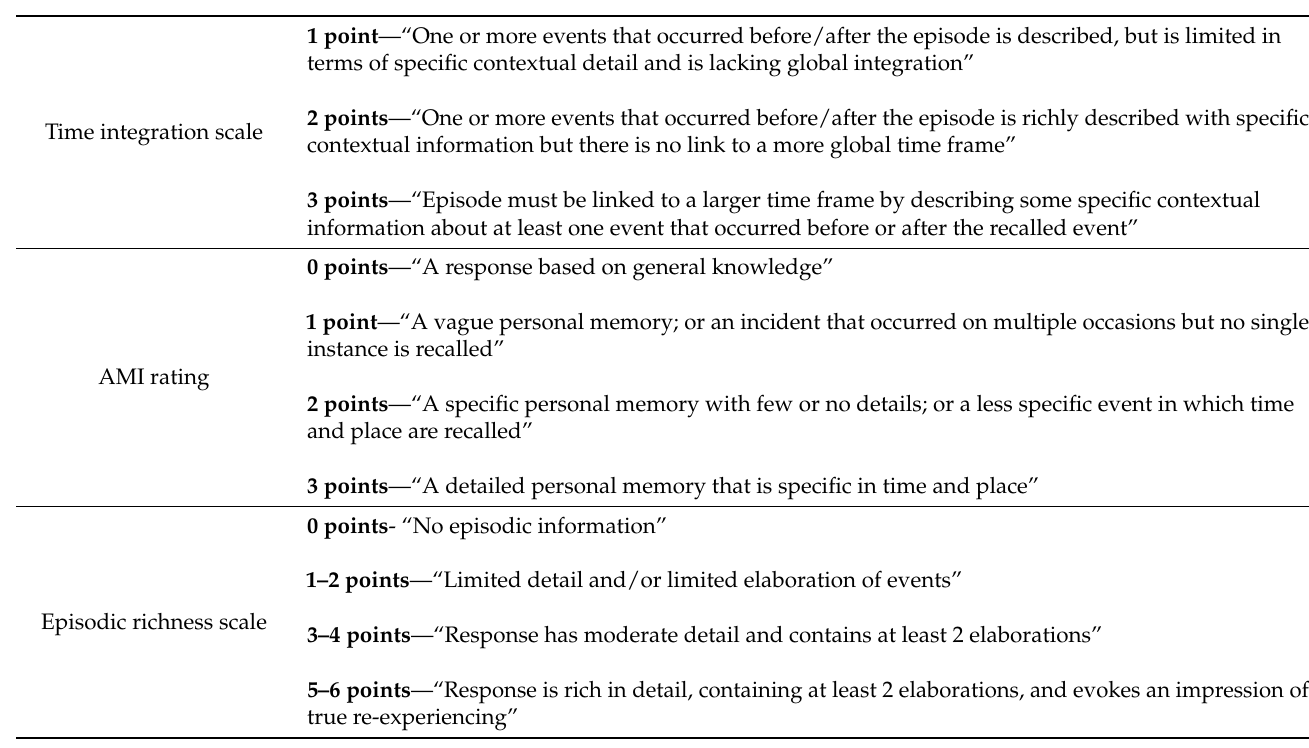
Table 3. Ratings by independent